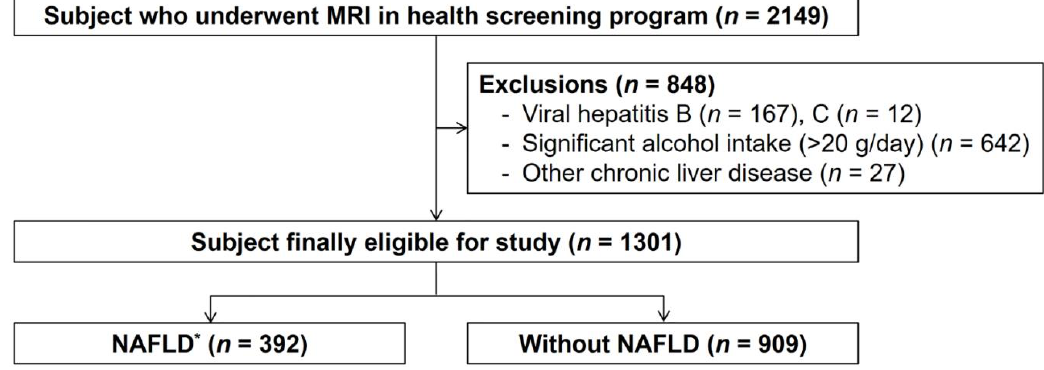
Figure 1. Flow chart showing enrollment of participants for this study. * NAFLD = Non-alcoholic fatty liver disease. Fatty liver was defined as hepatic fat fraction ≥ 5% on magnetic resonance imaging.